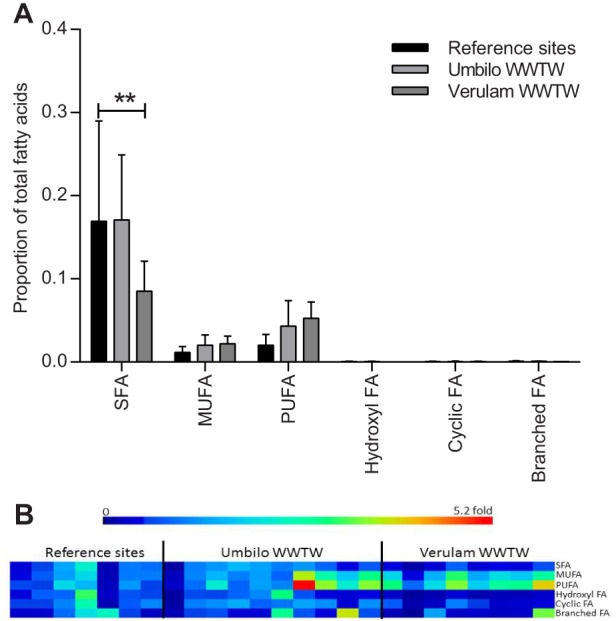
Phospholipid fatty acids per class in N. nana brown adipose tissue. (A) Mean phospholipid fatty acid concentrations (error bars=s.d.) per class in brown adipose tissue of N. nana bats collected from reference sites, Verulam WWTW and Umbilo WWTW. Asterisks indicate significant differences between sites as derived from two-way ANOVA followed by Tukey's multiple comparisons test. **P<0.01. (B) Heat map representing fatty acid concentrations in brown adipose tissue of individual bats relative to the average of the reference site, with each column presenting an individual bat.